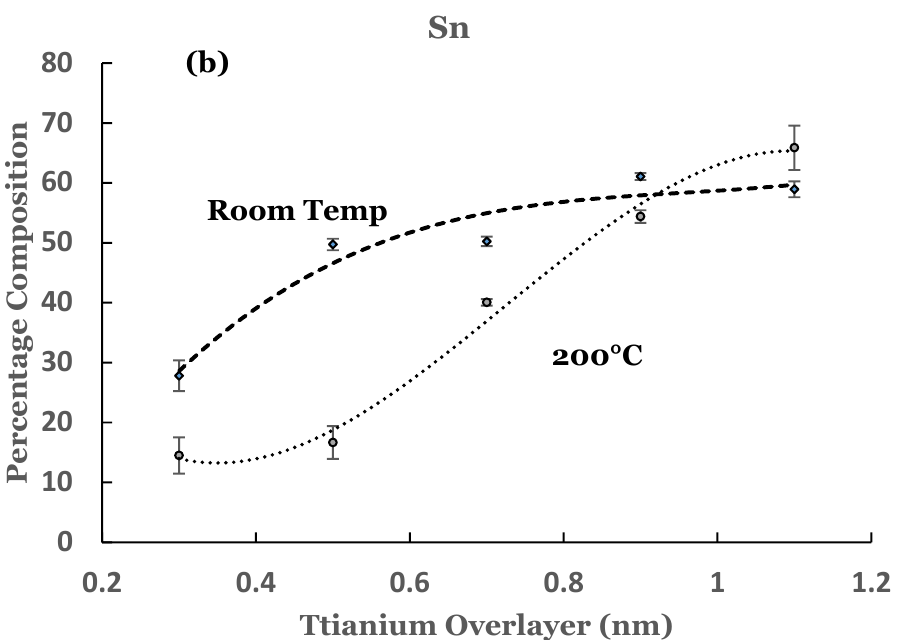
Figure 3. ( a ) Percentage composition of SnO 2 as a function of the thickness of the titanium overlayer in the two sets of samples, and ( b ) percentage composition of elemental Sn as a function of the thickness of the titanium overlayer in the two sets of samples. The lines serve as a guide for the trend in the data. The error bars are also included.